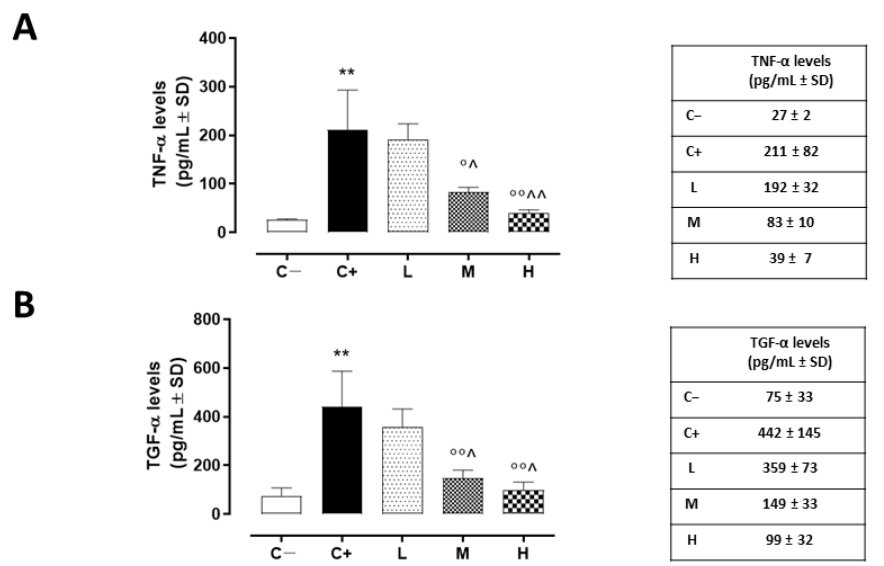
Figure 4. ( A ) Corneal TNF- α (pg/mL ± SD) and ( B ) TGF- α (pg/mL ± SD) levels in the TSP-1 KO mice euthanized at 6 weeks of age as a negative control for SS-associated dry eye (C − ); TSP-1 KO mice euthanized at 12 weeks of age as a positive control for SS-associated dry eye (C+); and TSP-1 KO mice supplied with low (L), medium (M), and high (H) doses of vitamin D3 (1000, 8000, and 20,000 IU/kg/week, respectively), from week 6 to week 12 of age. N = 5 corneas per group. ** p < 0.01 vs. C − ; ° p < 0.05 and °° p < 0.01 vs. C+; ^ p < 0.05 and ^^ p < 0.01 vs. L.